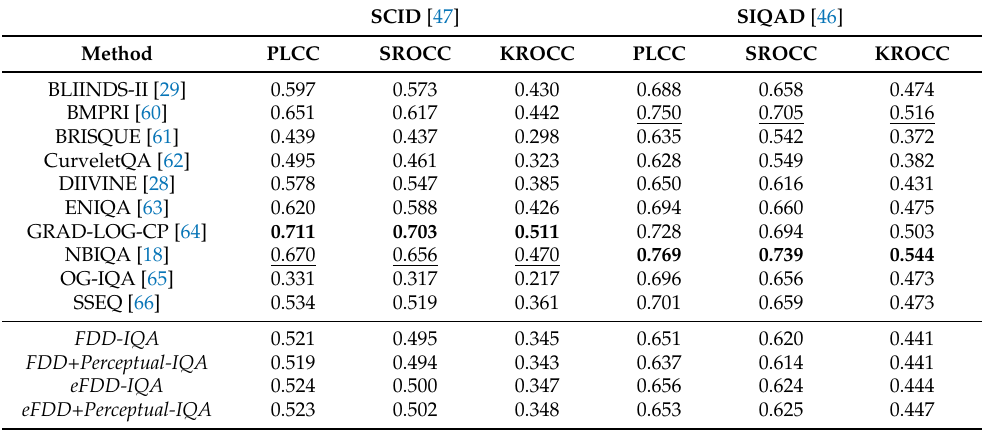
Table 11. Comparison of FDD-based NR-IQA methods to the state-of-the-art on screen content images (SCID [47] and SIQAD [46]). Median PLCC, SROCC, and KROCC values were measured